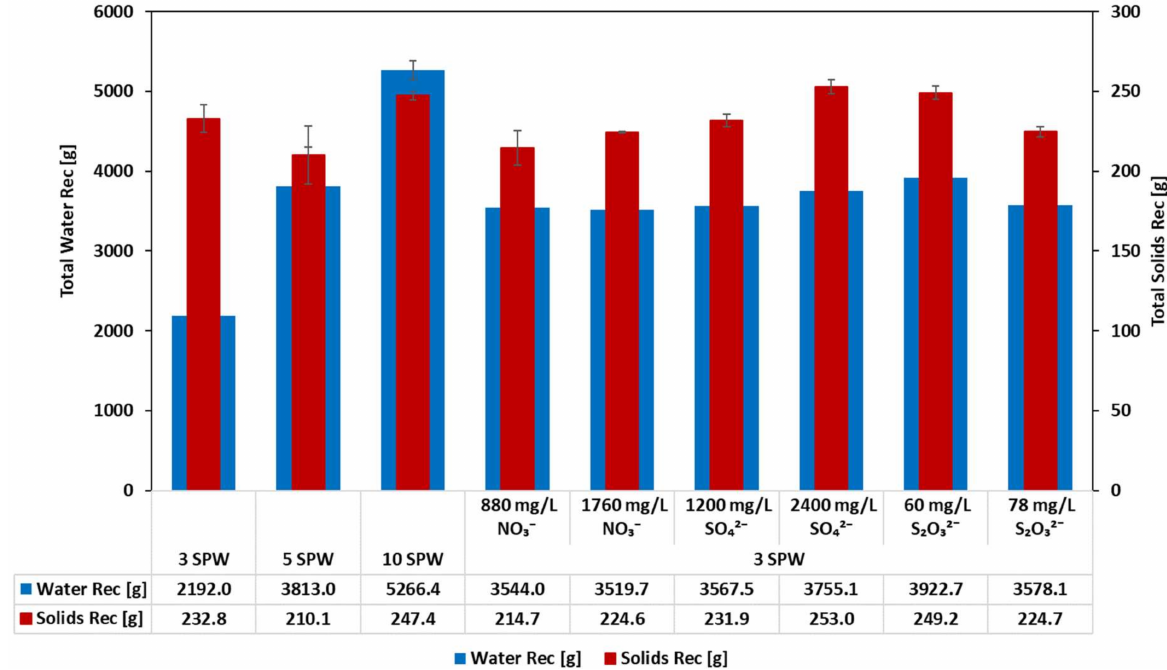
Figure 2. Final Water Rec vs. Solids Rec at different anion spiking concentrations, where ‘Rec’ refers to